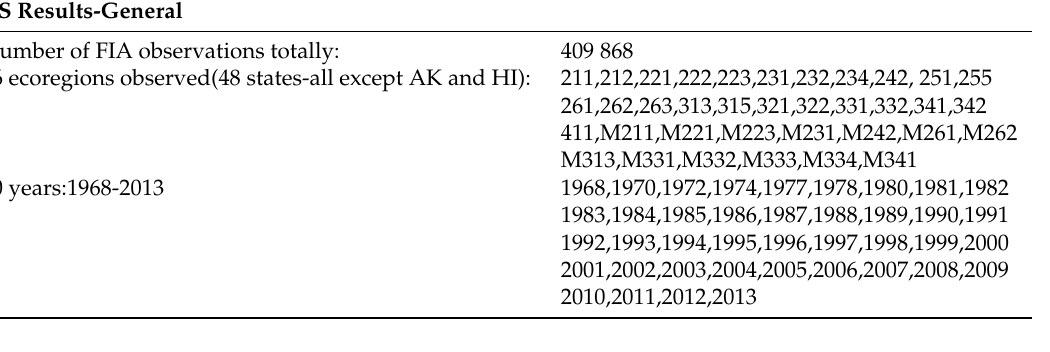
Table 1. General statistics of USA data.